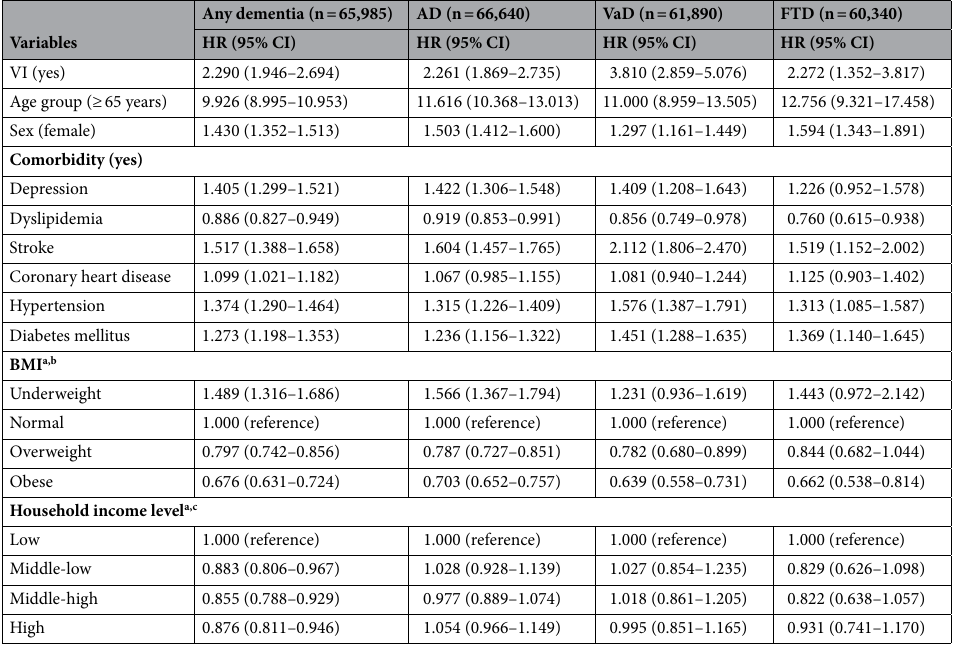
Table 3. Sensitivity analyses by additional adjustment with comorbidities, BMI and household income level according to sub-types of dementia. VI = visual impairment; HR = hazard ratio; CI = confidence interval; AD = Alzheimer’s disease; VaD = vascular dementia; FTD = frontotemporal dementia; BMI = body mass index. a There exist missing values in data: 12,713 (19.3%) and 5000 (7.6%) of the entire population for BMI and household income level, respectively. b BMI was classified as normal (18.5–22.9), underweight (< 18.5), overweight (23–24.9), and obese (≥ 25). c According to medical insurance fee, household income level was classified as low (1–5 ventiles), middle-low (6–10 ventiles), middle-high (11–15 ventiles), and high (16–20